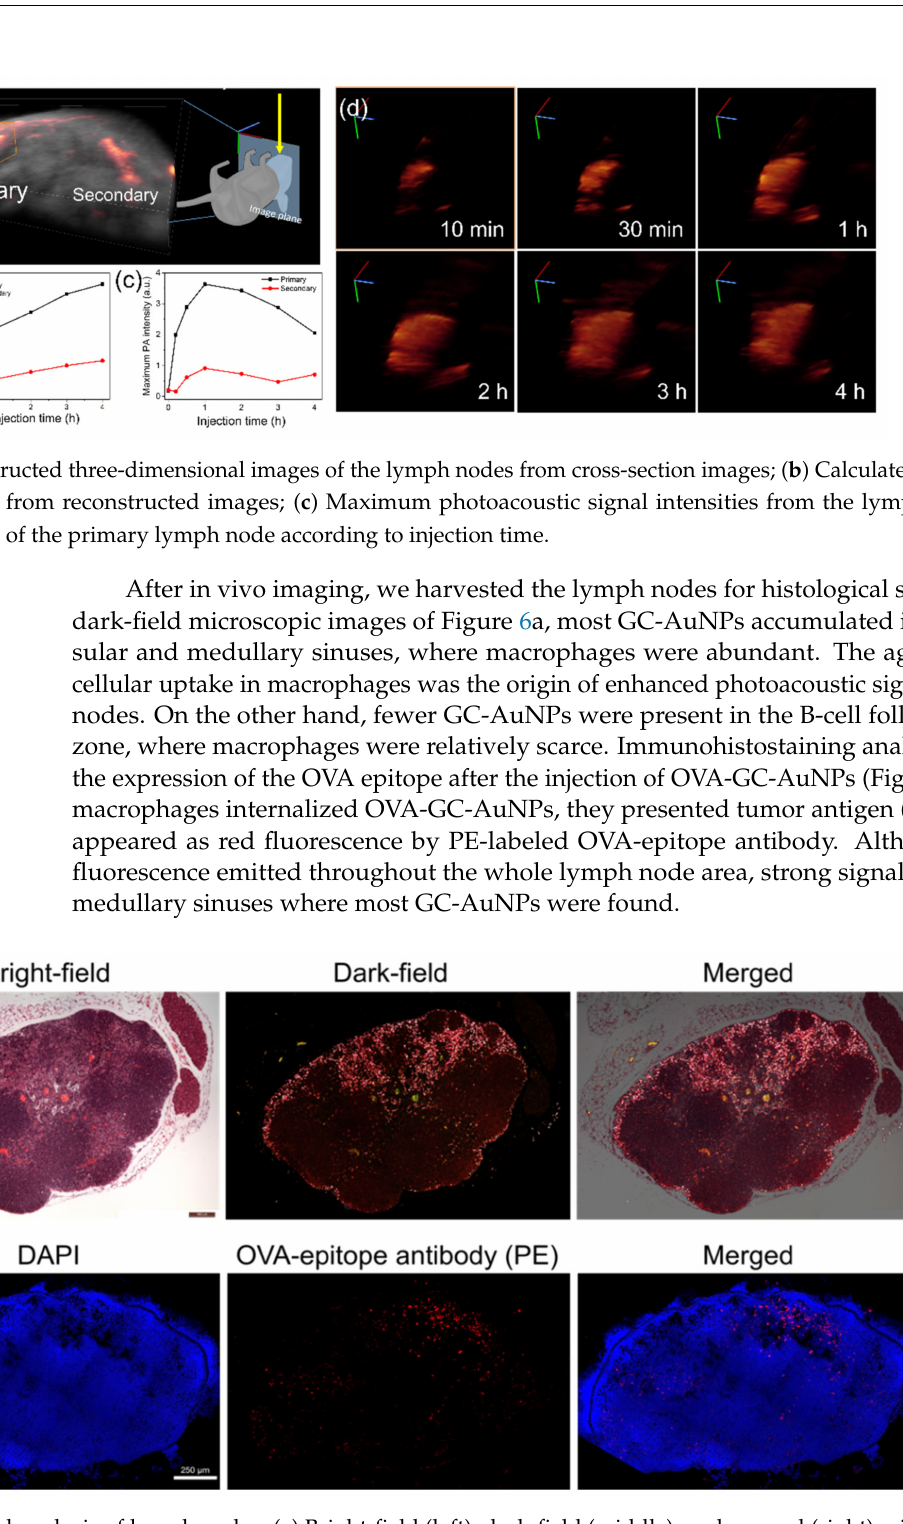
Figure 6. Histological analysis of lymph nodes: ( a ) Bright-field (left), dark-field (middle), and merged (right) microscopic images of a histological sample of the cervical lymph node after the accumulation of GC-AuNPs. In the dark-field images, most signals of GC-AuNPs were found in the subcapsular and medullary sinuses where macrophages are abundant; ( b ) Fluorescent images of the cervical lymph nodes after the injection of OVA-GC-AuNPs. The red fluorescent color indicated the expression of the OVA epitope. Although the OVA epitope was observed throughout the whole lymph node area, the majority centered on medullary